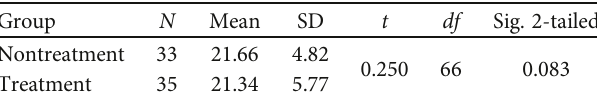
T ABLE 1: Independent samples t -test results for the treatment group and nontreatment group on preintervention test.